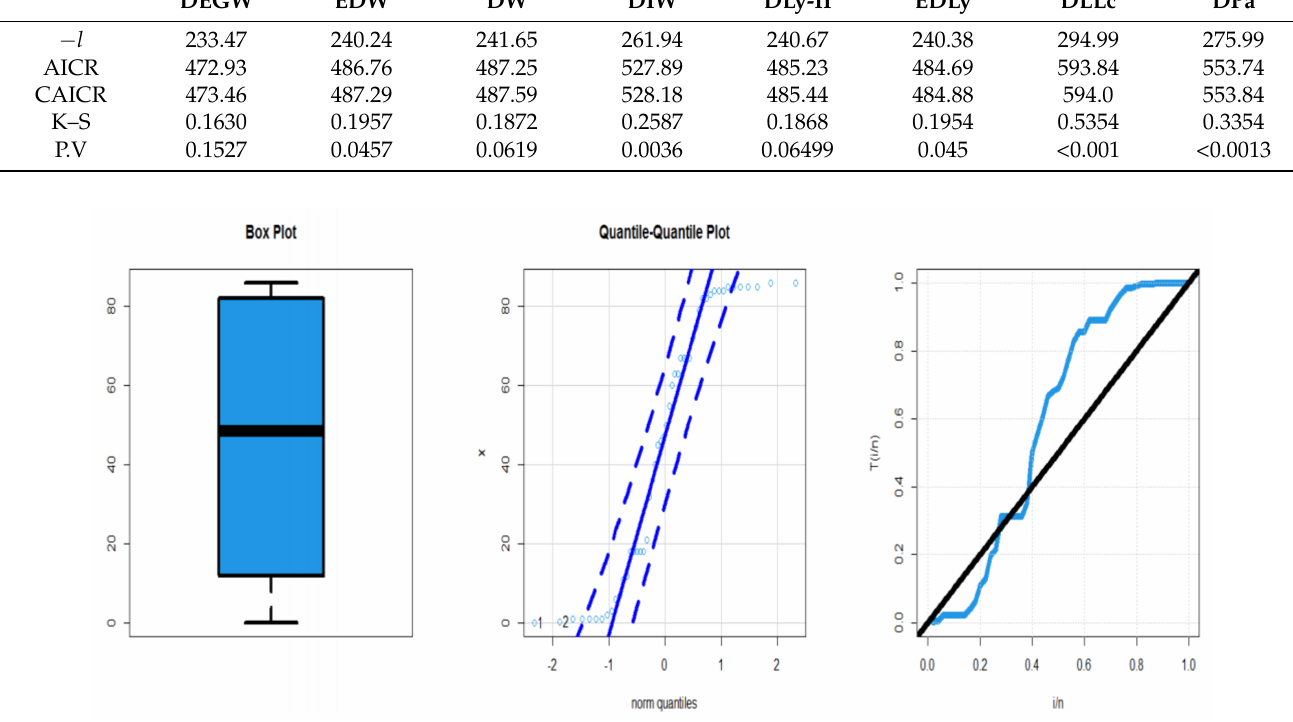
Figure 7. Box, Q-Q, and TTT plots for dataset I.